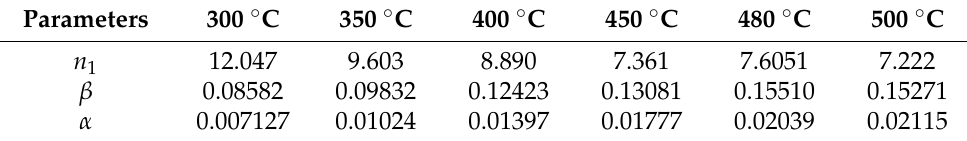
Figure 7. The fitting curves for ln σ − ln ε . Table 2. The values of n 1 , β and α under different deformation conditions.